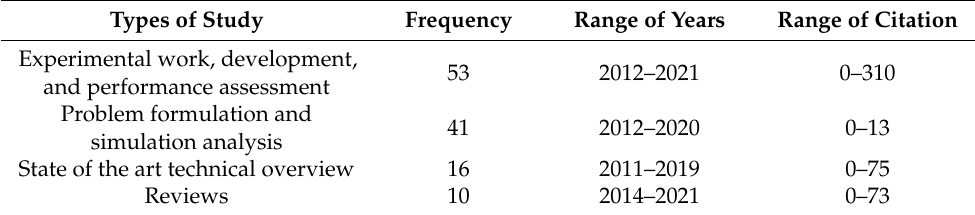
Table 4. Distribution of Papers According to Types of Study.